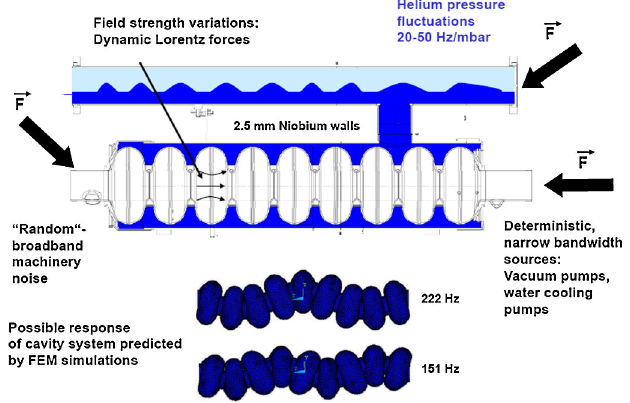
FIG. 3. (Color) Possible detuning sources for TESLA cavities and their mechanical